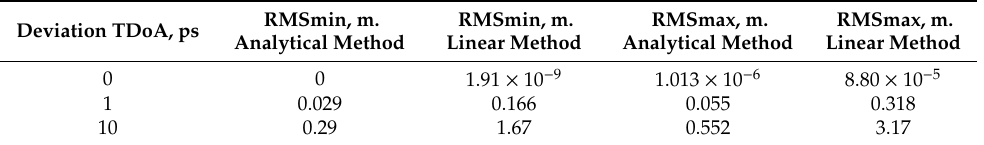
Table 3. RMS min and RMS max for analytical and linear methods